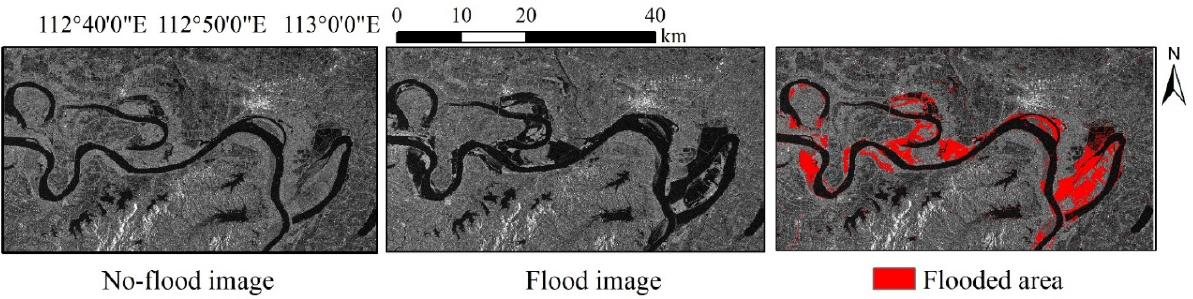
Figure A2. Flood detected in the middle reaches of the Yang tz e River in 2020.